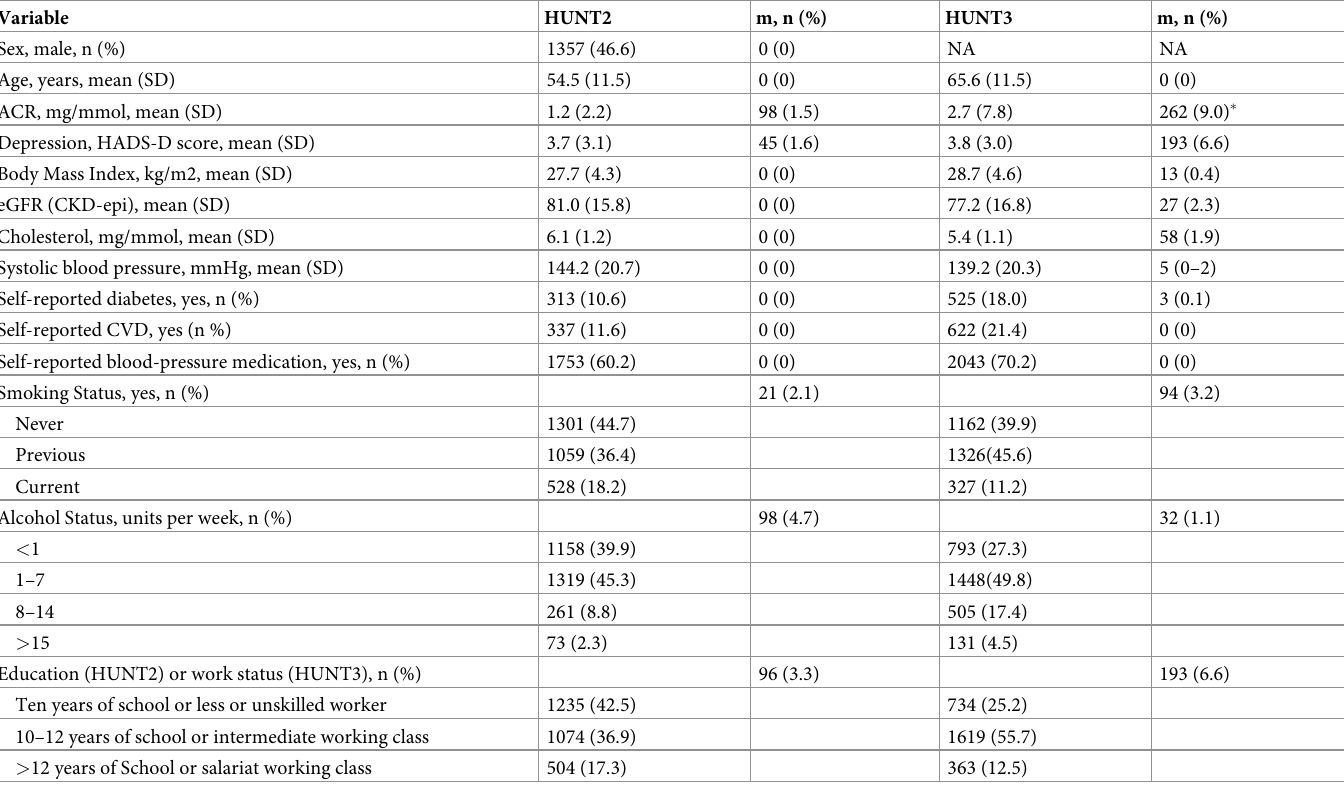
Table 1. Baseline characteristics of the participants at HUNT2 (1995–97) and HUNT3 (2006–2008), n =